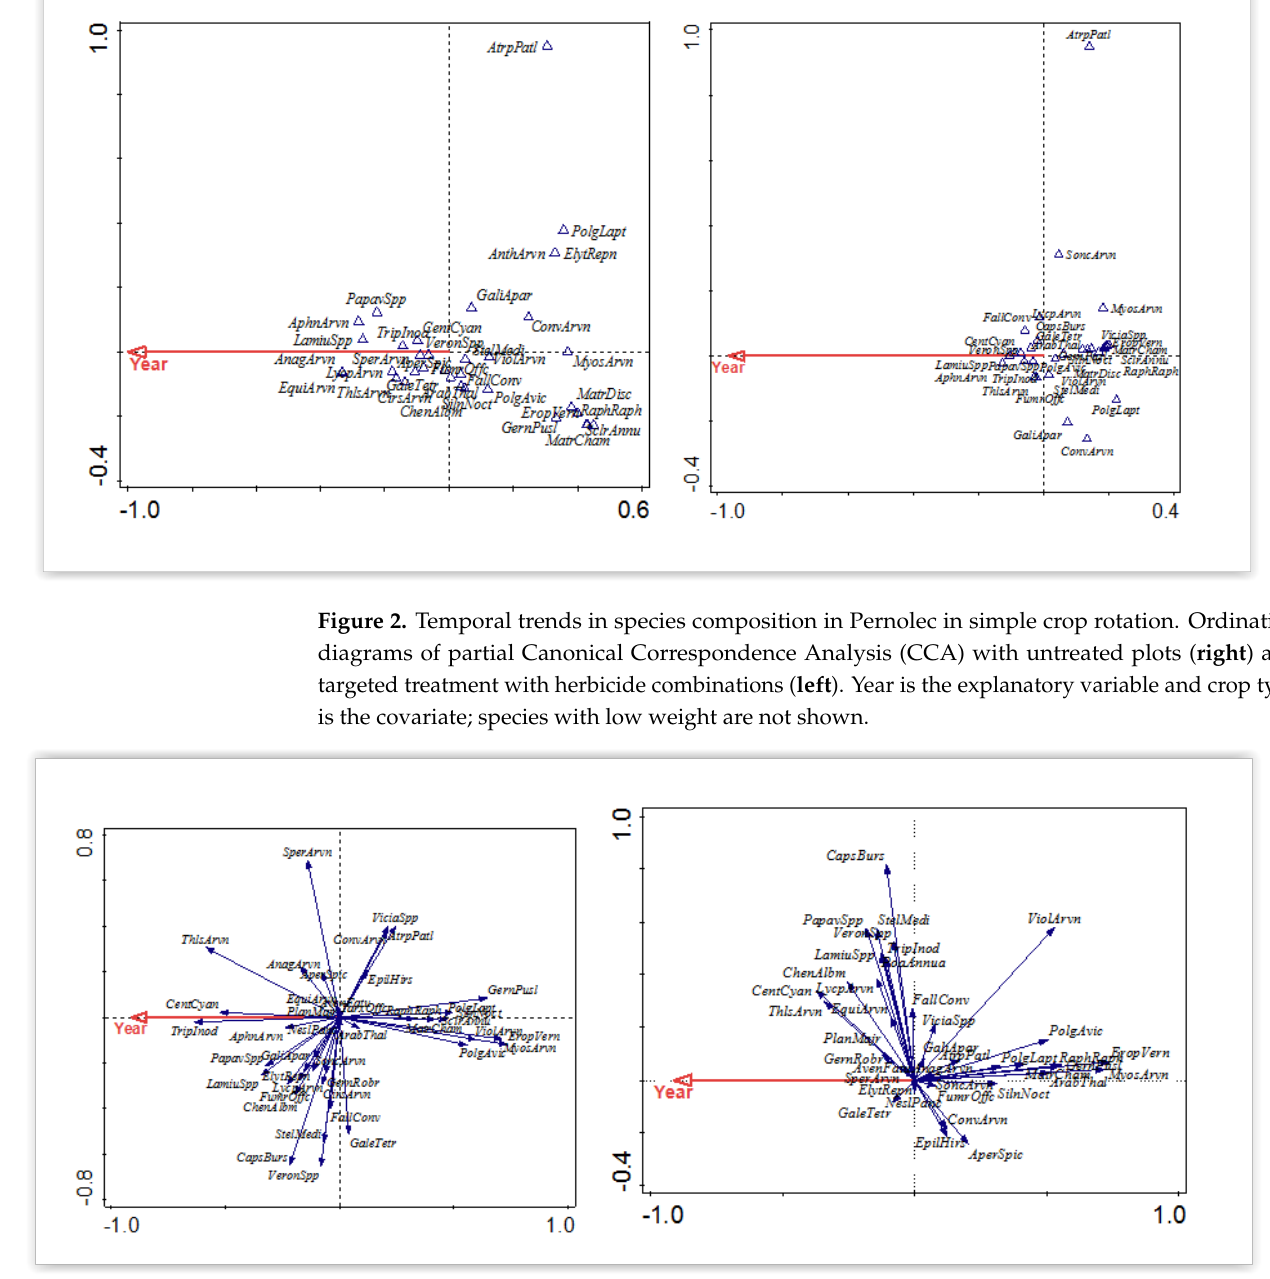
Figure 4. Temporal trends in species composition in Pernolec at plots treated with synthetic auxins. Ordination diagrams of partial Redundancy Analysis (RDA). Year is the explanatory variable and crop type is the covariate; species with low weight are not shown. Finally, many weed species responded to crop type (Figure 5). While Apera spica- venti , Arabidopsis thaliana , Papaver spp. and Tripleurospermum inodorum winter annuals were associated with winter cereals; the Fallopia convolvulus , Chenopodium album , Galeopsis tetrahit and Anagallis arvensis summer annuals were associated with spring cereals and the Plantago major L., Taraxacum sect. Ruderalia Kirschner, H.Øll gaard et Štěpánek and Equise- tum arvense L. perennial weeds were often present in root crops.